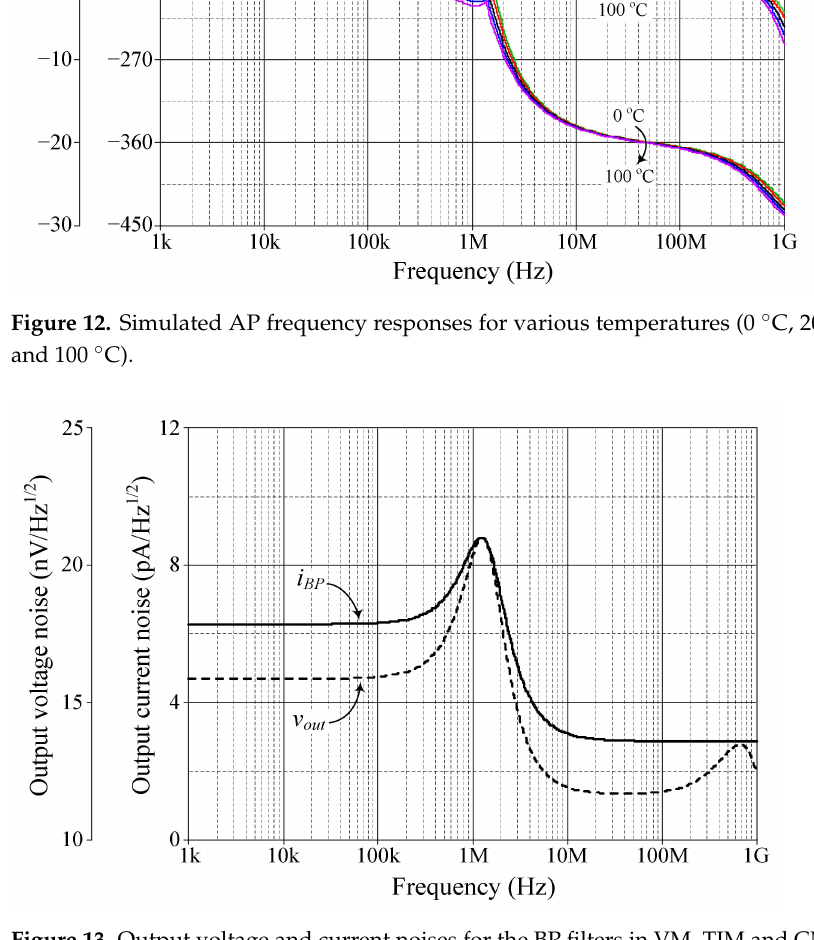
Figure 13. Output voltage and current noises for the BP filters in VM, TIM and CM,